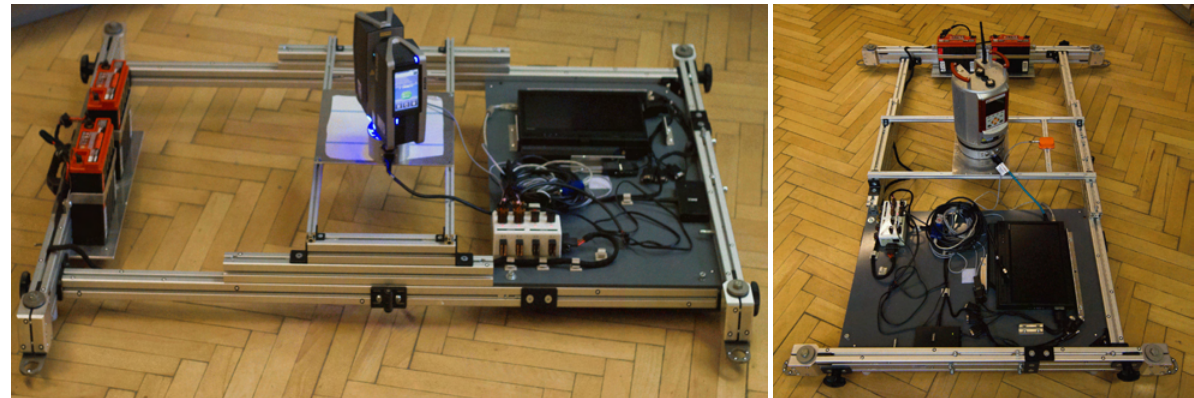
Figure 1: Left: Sensor skid, a.k.a. work-holding fixture, equipped with a FARO Focus 3D laser scanner. Right: Skid with a Riegl VZ-400 laser scanner. Both skids are also equipped with a low-price MEMS IMU (xsens